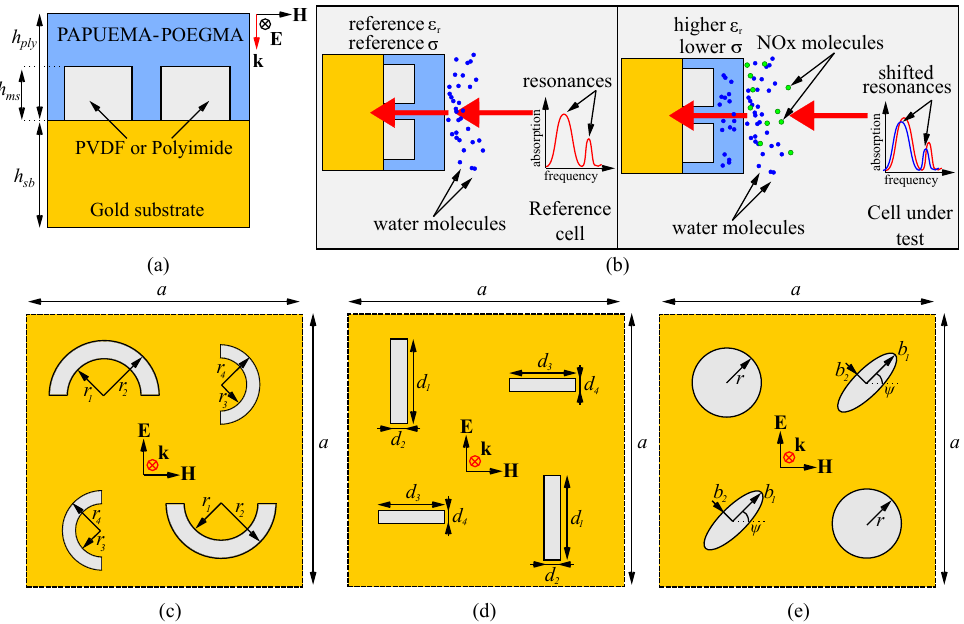
Figure 1. The structure and operating principles of the metasurface-based NO 2 gas sensors: ( a ) the layers comprising the architecture with their respective thicknesses; ( b ) example of operating the reference and test metasurfaces: the reference cell (left side) is operated in the absence of NO 2 molecules, and the PAPUEMA-POEGMA layer exhibits reference values of the relative permittivity (cid:101) r and electric conductivity σ . The test cell (right side) is operated in the presence of NO 2 molecules, which increase the hydrophyllic state of the PAPUEMA-POEGMA and considerably increase both (cid:101) r and σ . The absorption readout of the cell under test is modified considerably with respect to the reference cell, usually in the form of prominent absorption peaks, if the reference is set to a fully-reflective behavior; ( c ) the incomplete ring metasurface layout; ( d ) the rod metasurface layout; and ( e ) the cylinder metasurface layout. Table 1. Electrical properties of the polymer elements in the metasurface